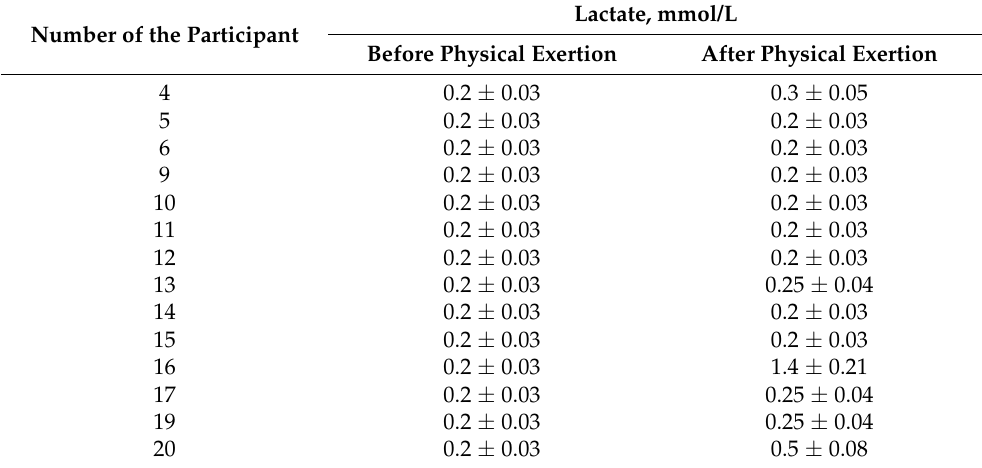
Table 2. Saliva supernatant parameter before and after physical exertion (M ± SD). Number of the